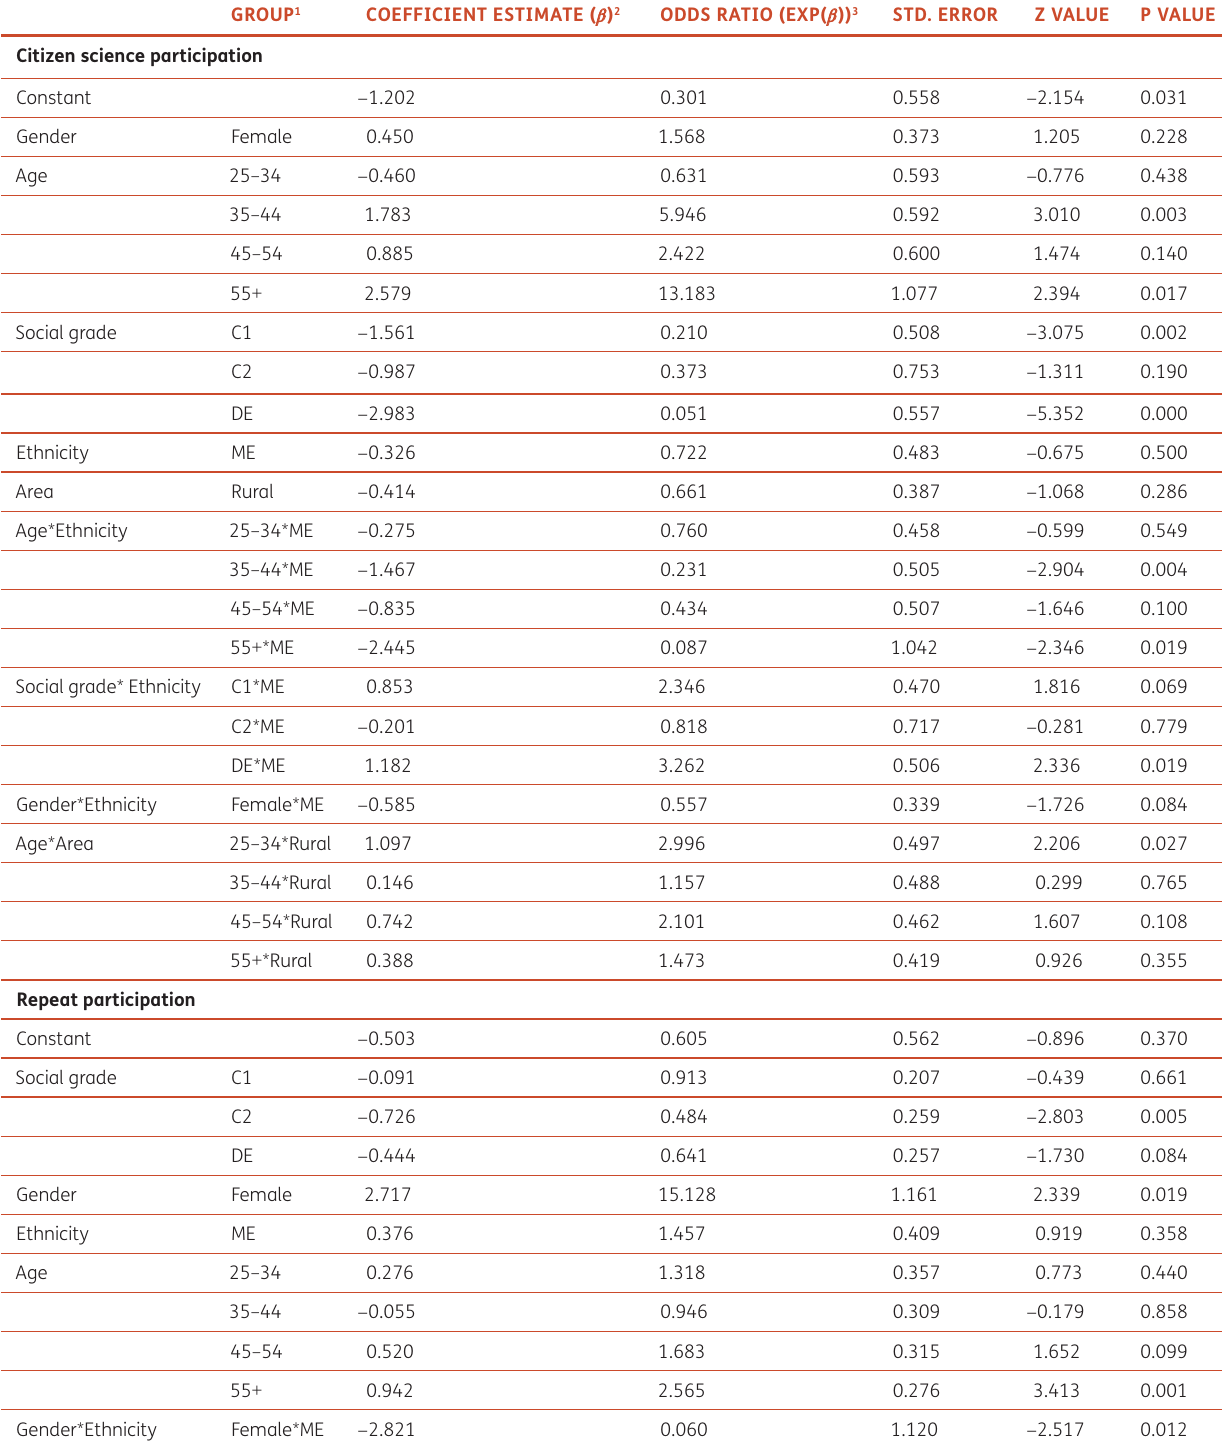
Table 2 Results of stepwise logistic regression models, showing the main effects variables and interactions retained in the minimal adequate